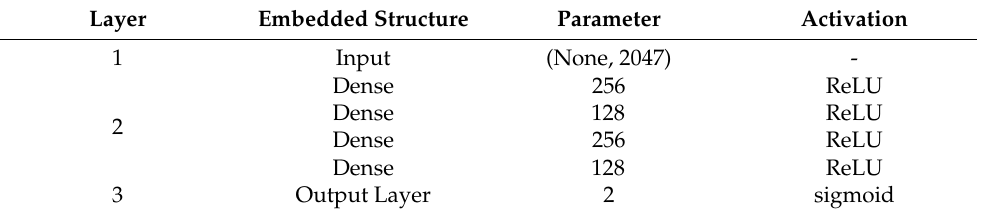
Table 1. UAV Detection Network.